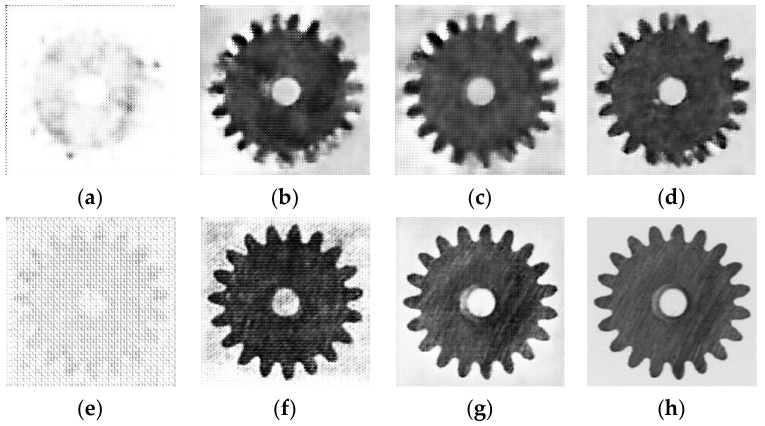
Figure 5. Scratch defect image generation effect: ( a ) 10 steps by original; ( b ) 200 steps by original; ( c ) 500 steps by original; ( d ) 1000 steps by original; ( e ) 10 steps by ROS; ( f ) 200 steps by ROS; ( g ) 500